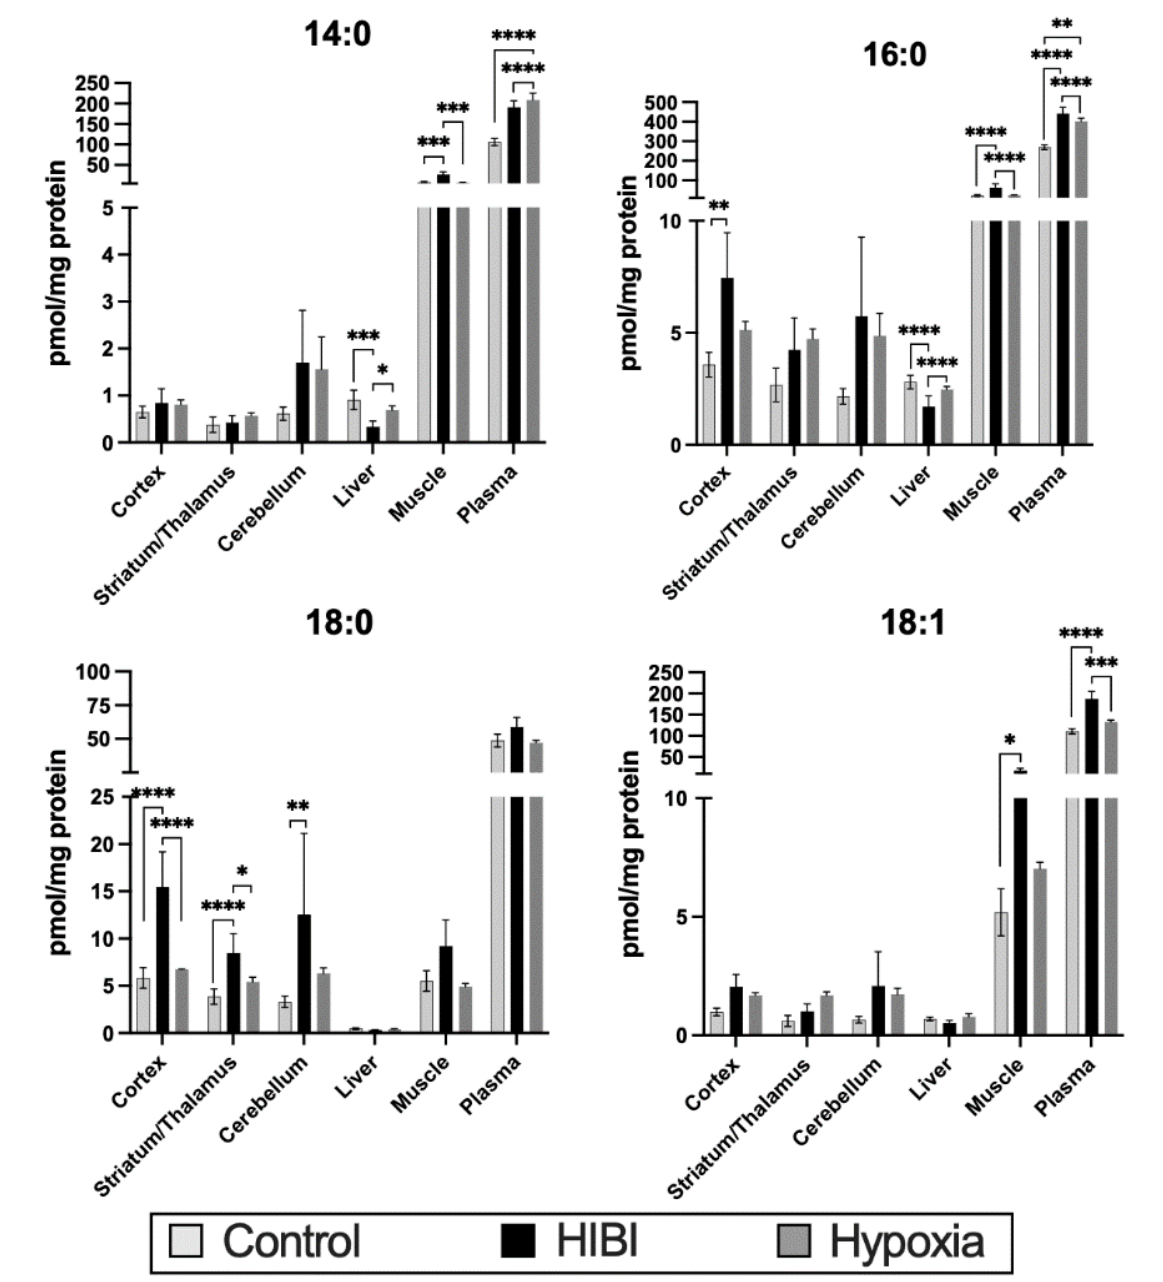
Figure 3. Levels of the four primarily altered acylcarnitines in the different tissues analyzed at 30 min after HIBI compared with hypoxia or controls. * p < 0.05, ** p < 0.01, *** p < 0.001, **** p < 0.0001.